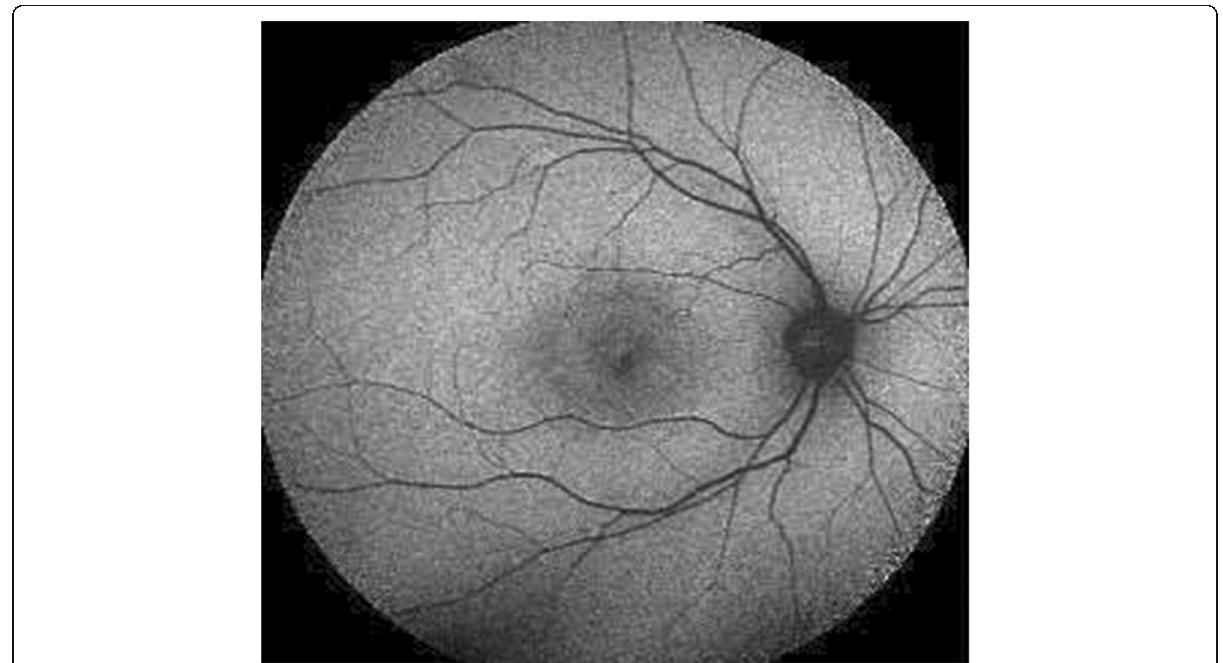
Fig. 3 Bull ’ s eye by fundus